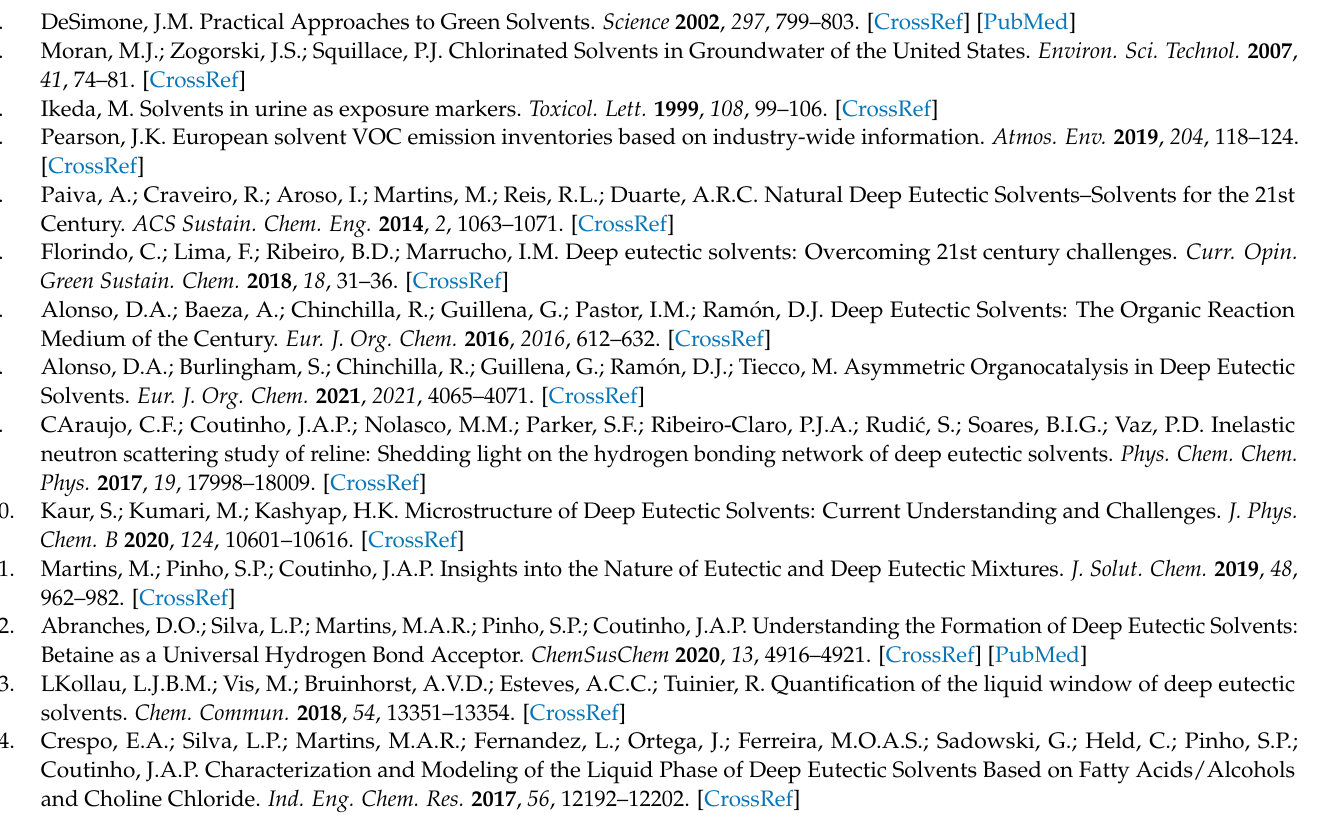
Figure S4: ratio of the mass of onion skin on the mass of the extracting DESs optimization. Table S1: HPLC Calibration data. Table S2: HPLC Method